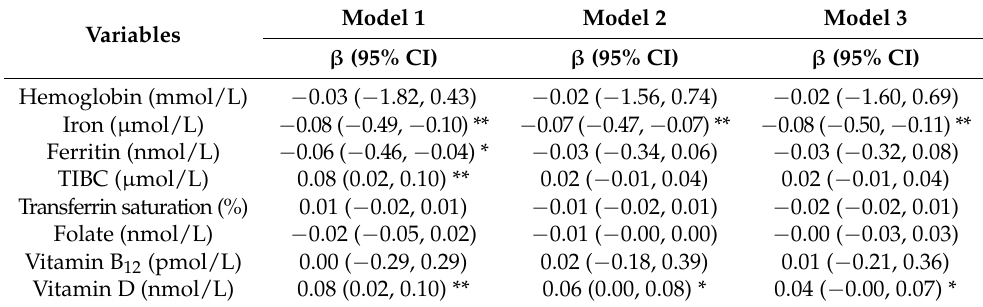
Table 4. The association of carnivore dietary pattern with anemia-related biochemical variables in serum evaluated by the generalized linear regression analysis 1